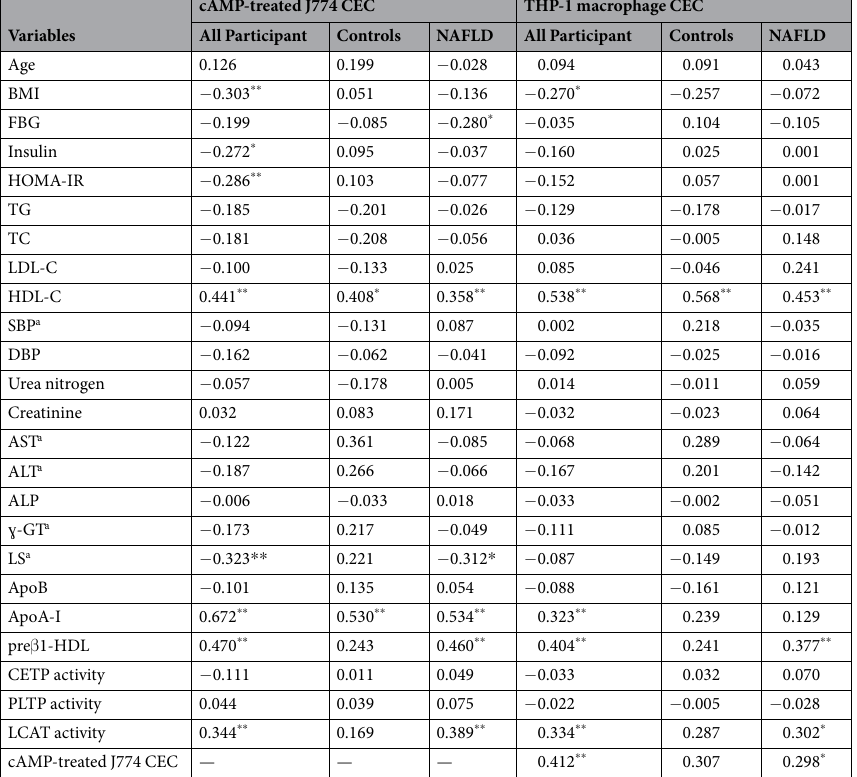
Table 2. Pearson correlation of cAMP-treated J774 CEC and THP-1 macrophage CEC with anthropometric and metabolic profiles. * p < 0.05 and ** p < 0.01. a Logarithmic transformation was